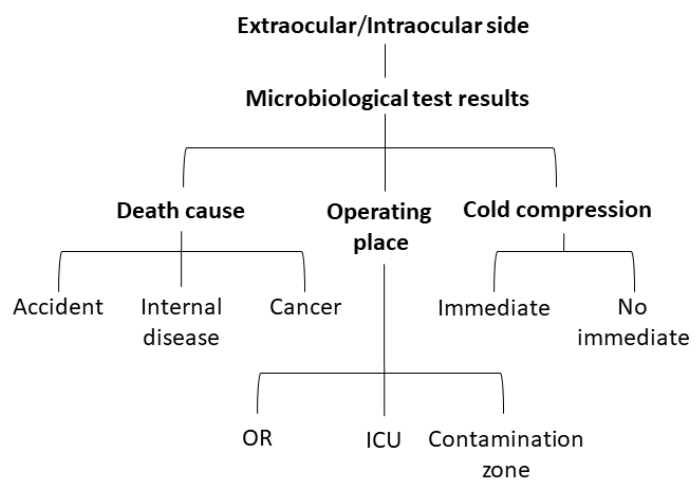
Figure 4. Group comparison of donor-associated factors with microbiological test results. The microbiological test results of the extraocular or intraocular side at the corneoscleral rim were also compared with three donor-associated factors including the cause of death, operating location, and cold compression time. OR, operating room; ICU, intensive care unit.